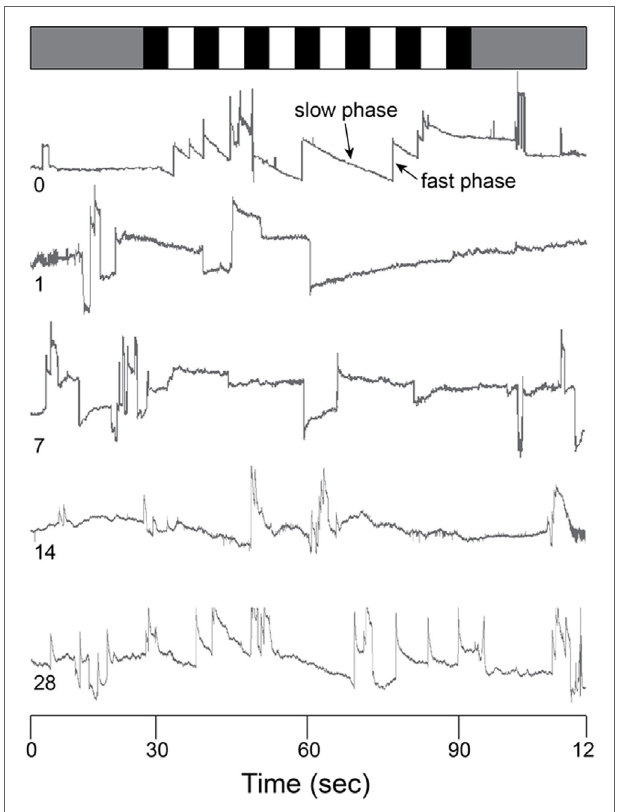
FigUre 4 | Raw OKN response. Eye position traces for 0 (control), 1, 7, 14, and 28 days post-blast exposure for one animal as a function of time (in s). Gray bar (top) indicates no motion stimulus. Alternating black and white bars indicate onset/offset of optokinetic stimulus. Slow phase and fast phase eye movements are indicated in the day 0 trace